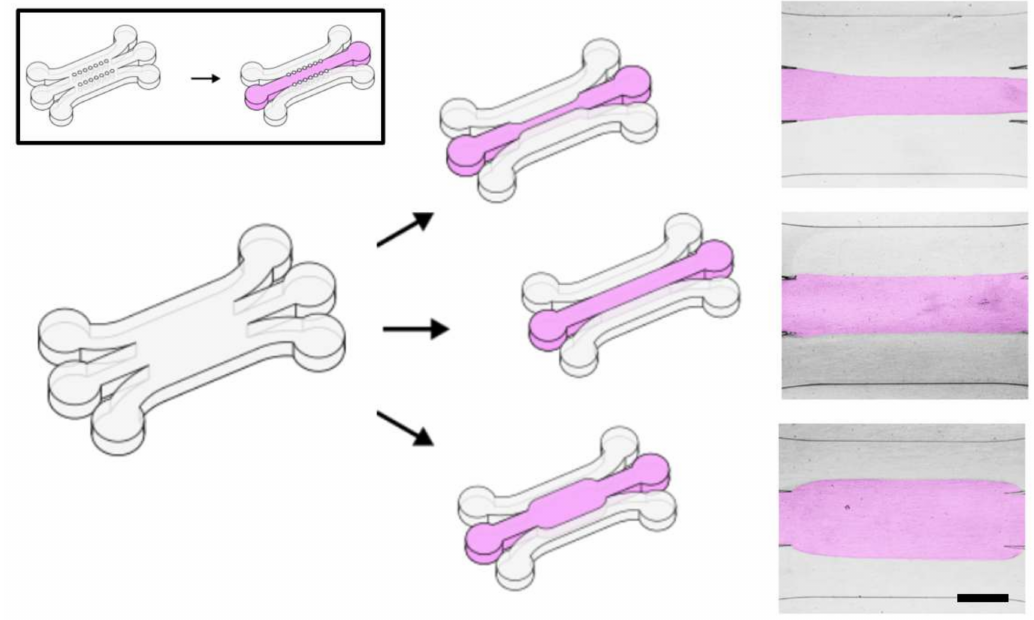
Figure 1. Local control of hydrophilicity allows patterning of biological hydrogels inside microfluidic devices without any geometrical constraints. Left: Schematic of 3-inlet, 3-outlet microfluidic devices. Empty channels are shown in white and gel-filled channels are shown in pink. Our devices have no confining geometry and therefore many di ff erent gel geometries are achievable in a single device geometry. Inset shows typical device found in the literature where geometry of the gel-filled region is fully determined by the device geometry, in this case with rows of micropillars. Right shows examples of 3 gels with geometry produced by our technique. Collagen gel is artificially colored pink for contrast. Scale bar is 0.5